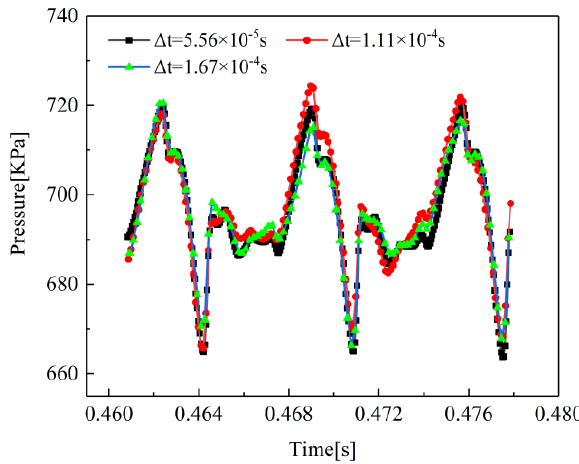
Figure 3. Verification of the time step independence.